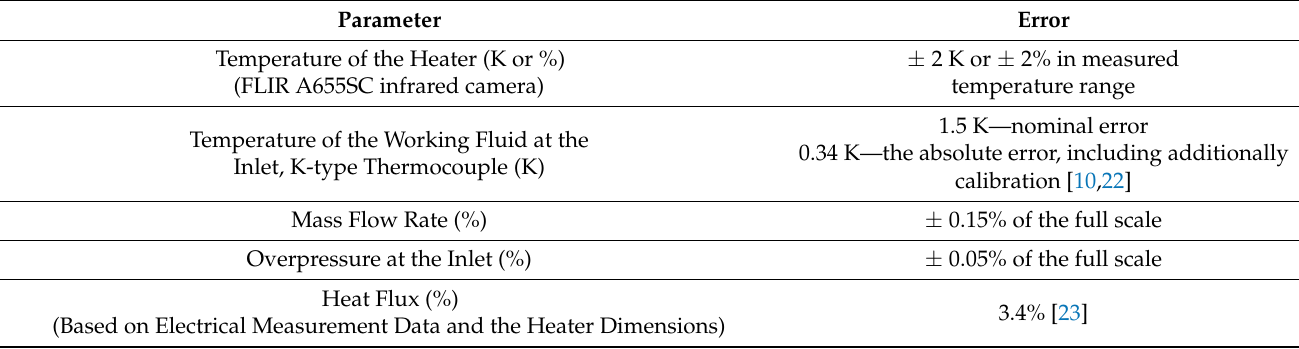
Table 2. Errors of the main experimental